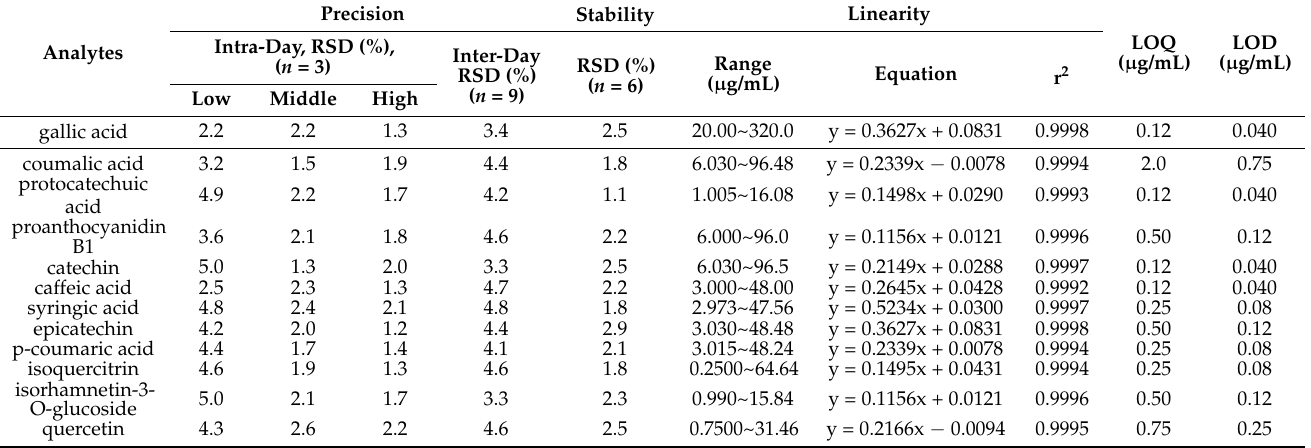
Figure 4. The typical reference chromatogram (top) and the typical chromatogram of red wine (bot- tom). gallic acid (1), coumalic acid (2), protocatechuic acid (3), proanthocyanidin B1 (4), catechins (5), caffeic acid (6), syringic acid (7), epicatechin (8), p-coumaric acid (9), isoquercitrin (10), isorhamnetin 3-O-glucoside (11) and quercetin (12). Table 4. Precision, stability, linearity, LODs and LOQs of 12 compounds from red